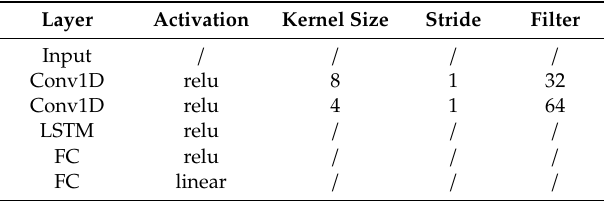
Table 4. The specifically structure parameters CNN-LSTM.